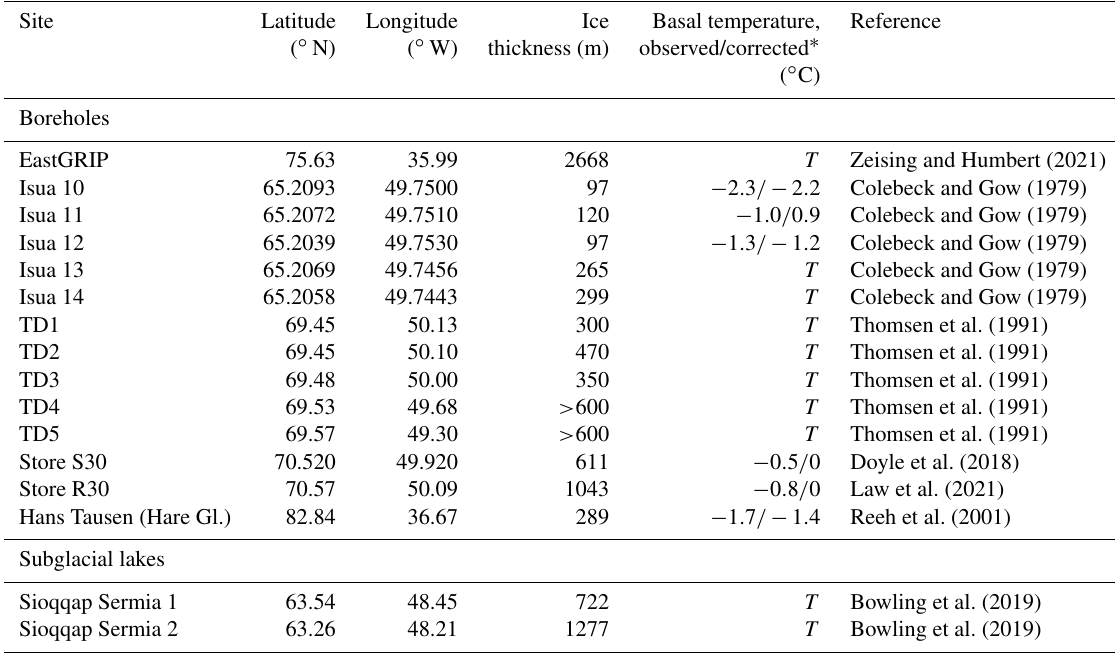
Table 1. Additional direct observations of basal thermal state from deep boreholes and subglacial lake detections. Site